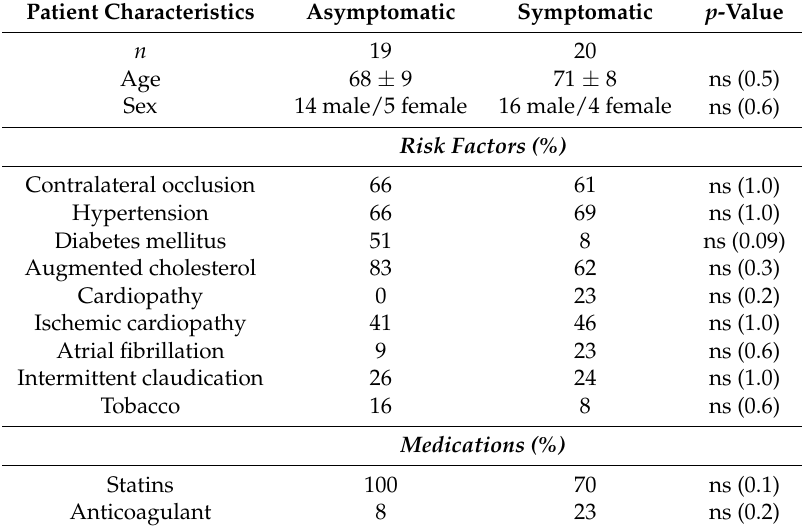
Table 1. Demographic and clinical data from asymptomatic and symptomatic patients. Statistical analysis was performed with the chi-square test for all parameters except age, for which the non-parametric Mann–Whitney U test was used. p -value ≤ 0.05 was considered significant. Patient